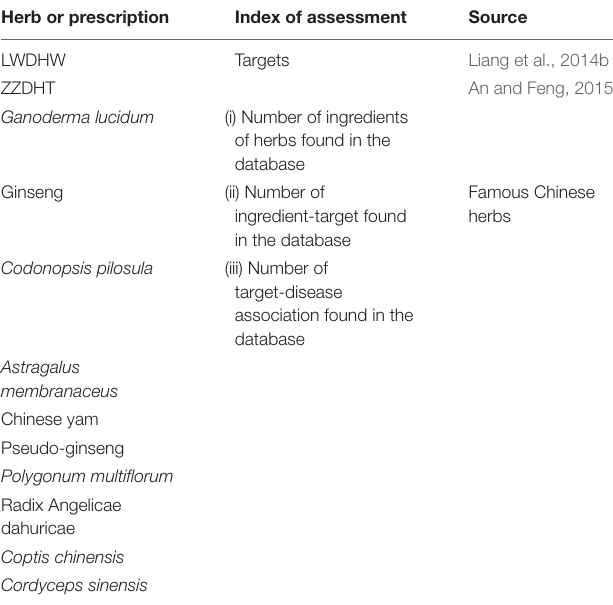
TABLE 3 | Detailed information on the data sets of herbs and